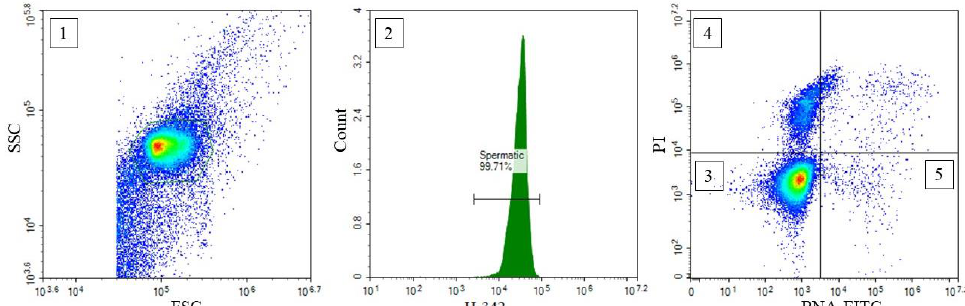
Figure 1. Flow cytometric gating strategy. A cluster of events was initially identified using a side scatter (SSC) versus forward scatter (FSC) bivariate histogram plot ( 1 ). Spermatic events were identified based on the gating set with the Hoechst-33342 stain (H-342; DNA content) ( 2 ). Finally, the percentage of spermatozoa with intact plasma membranes and intact acrosome—PAI ( 3 )—with damaged plasma membranes—PMD ( 4 )—and with damaged acrosomes—ACRD ( 5 )—were identified based on the propidium iodide (PI) and Arachis hypogea lectin PNA (PNA-FITC) signal intensities. Illustrative dot plots and histograms are shown.